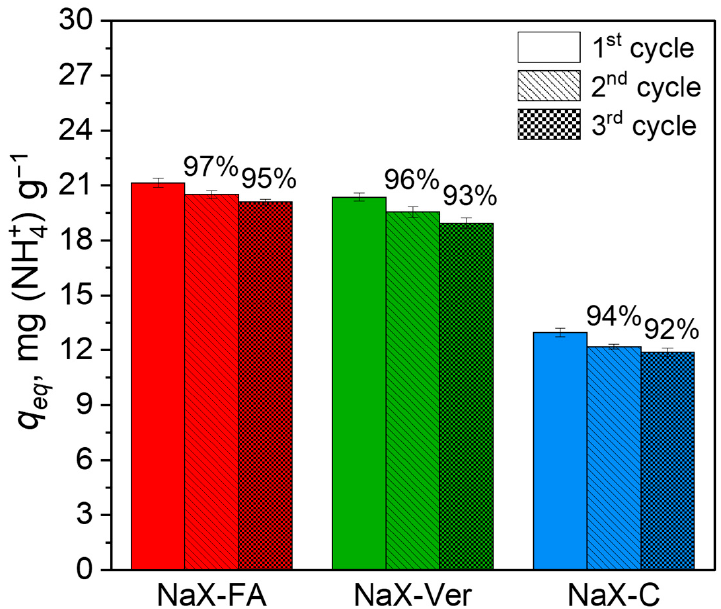
Figure 8. Ammonium ion adsorption capacities after three adsorption cycles. Error bars indicate the standard deviation of duplicate measurements.